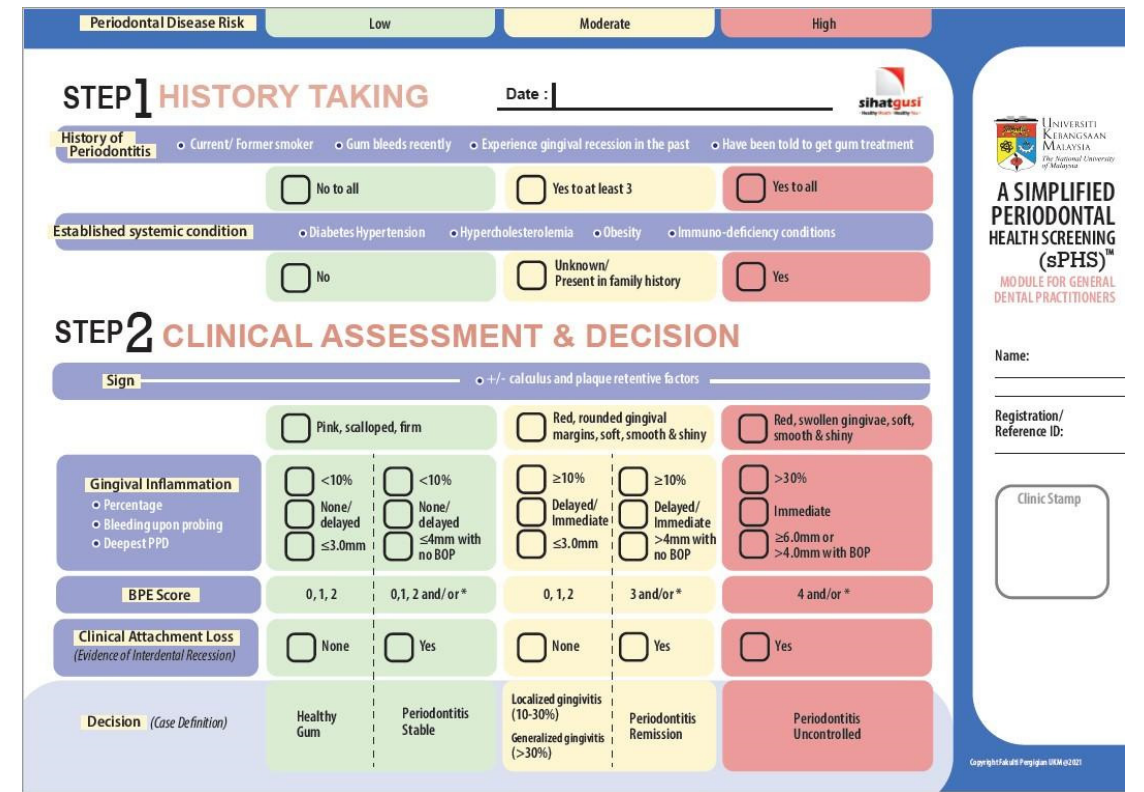
Figure 1. The finalised simplified Periodontal Health Screening Module.